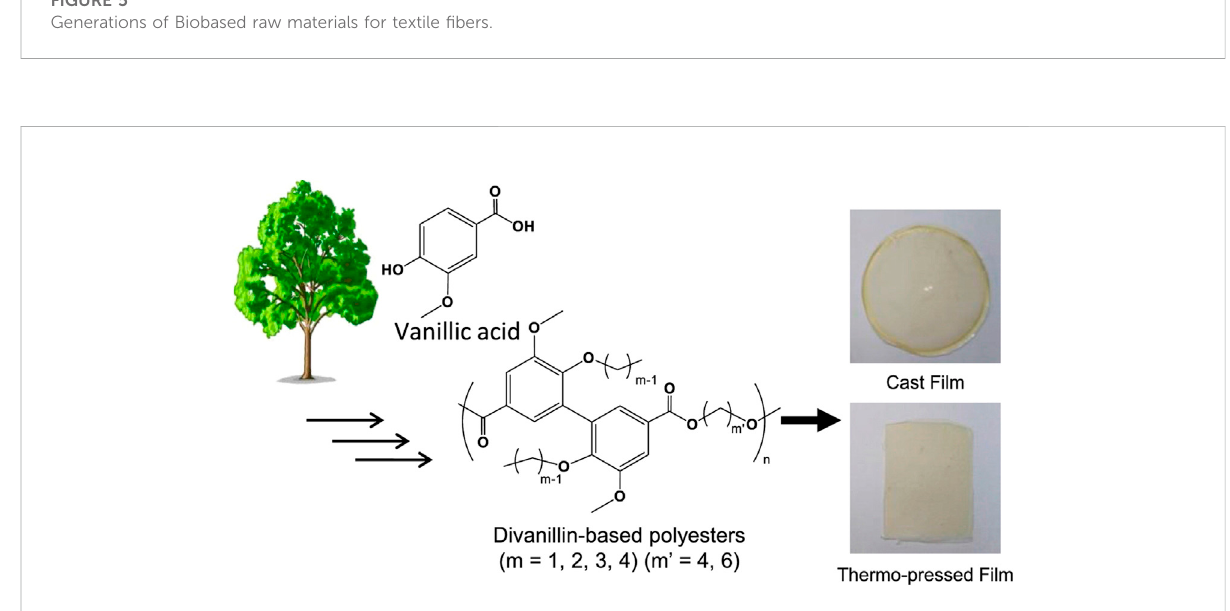
FIGURE 6 Synthesis and Film of Vanillin-based polyester (Enomoto and Iwata, 2020).